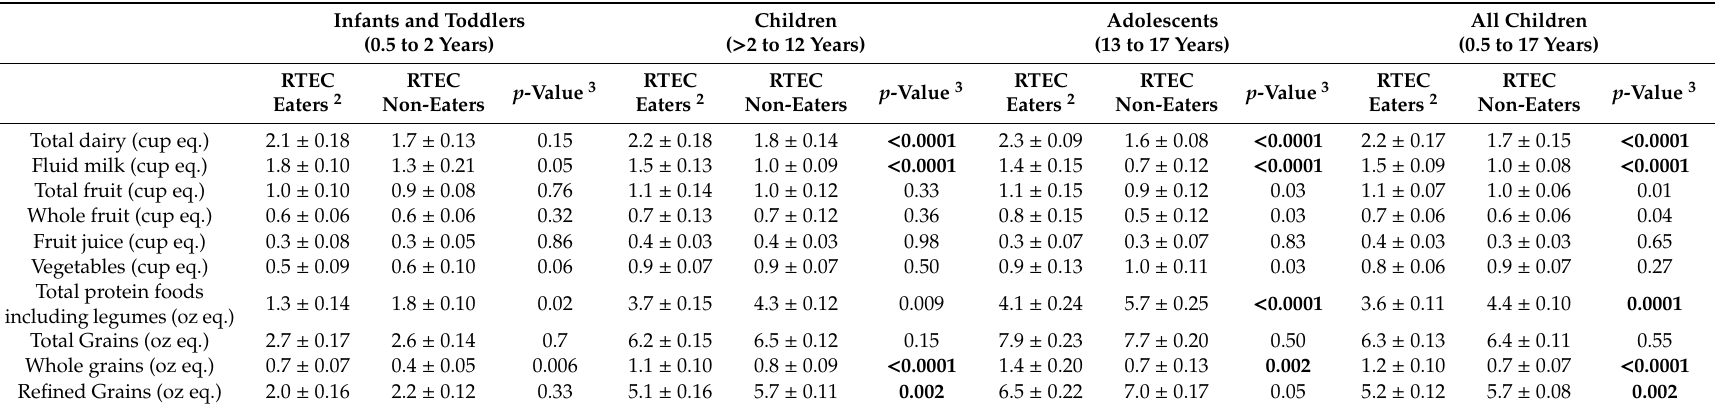
Table 3. Food group intake for children aged 0.5 to 17 years, by RTE cereal eating status from the Food Patterns Equivalents Database 2015–2016 1 .